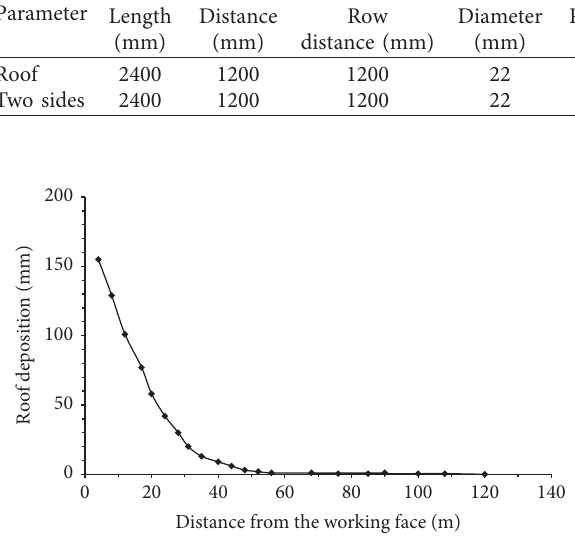
Figure 15: Roof deposition of 1905S haulage entry. Figure 16: Roof deposition of 1905S air-return entry.